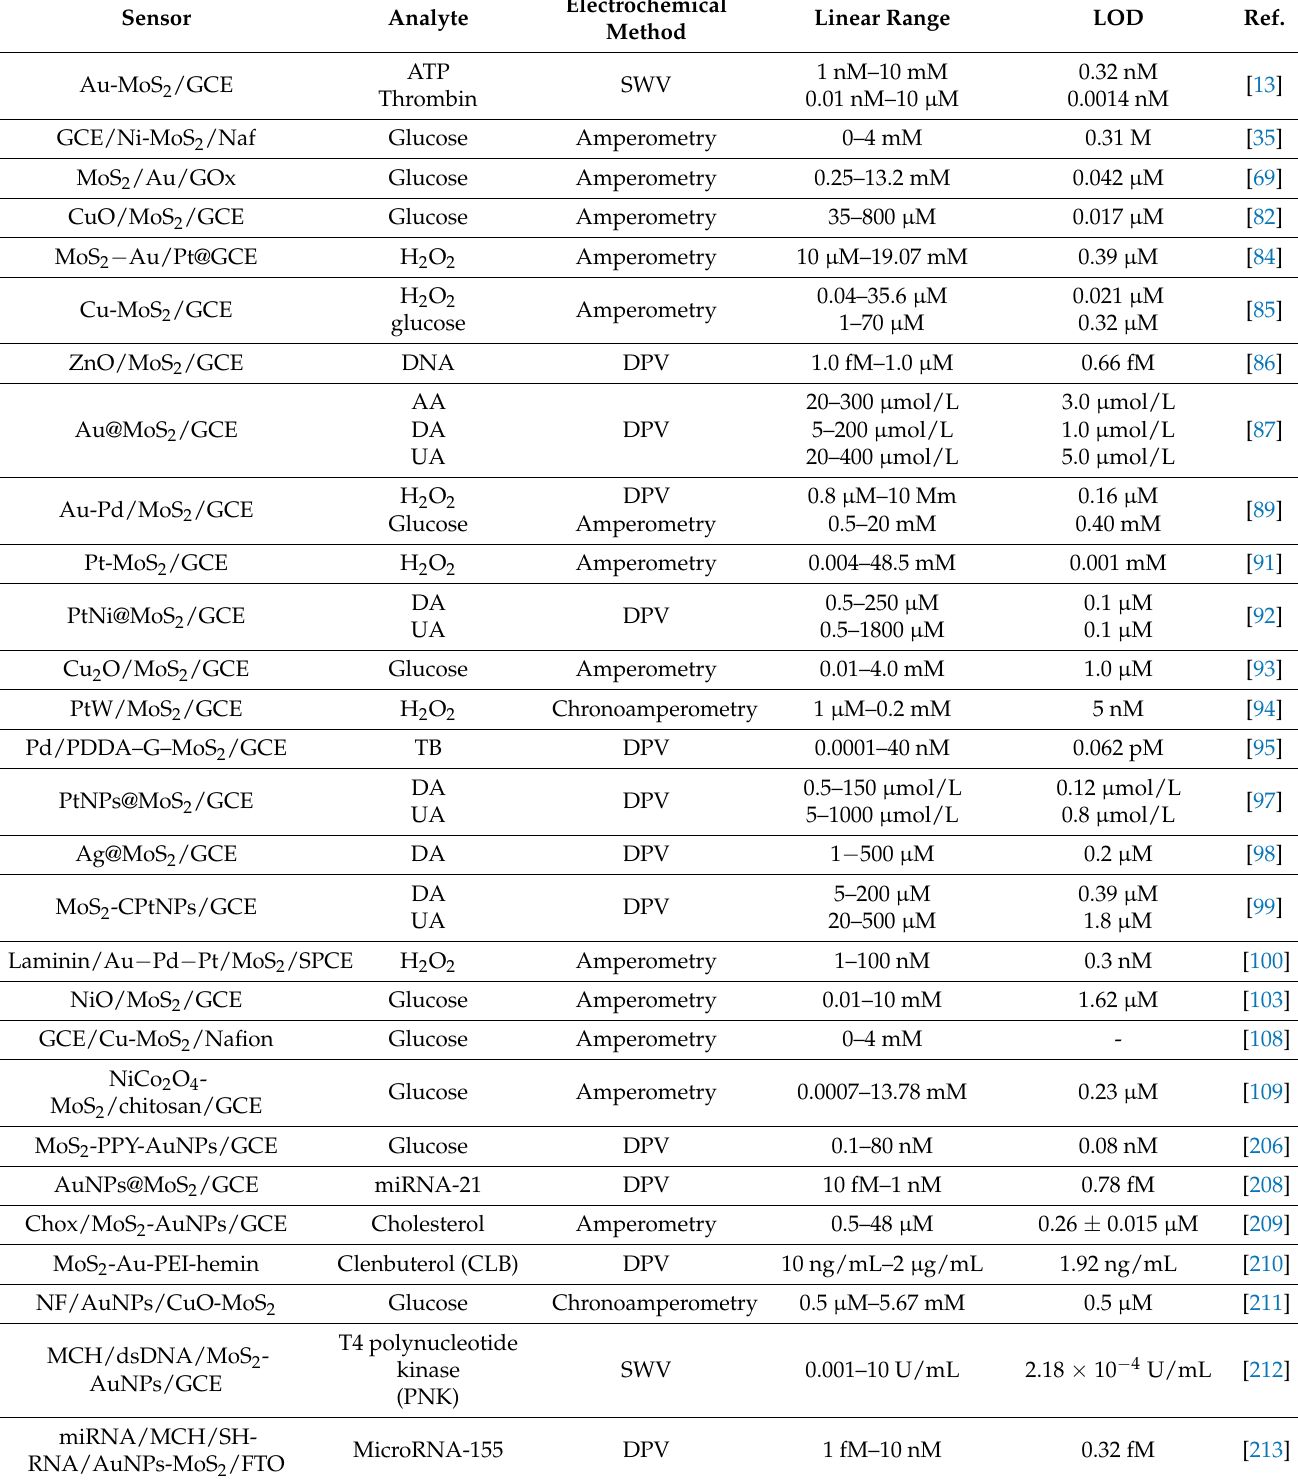
Table 2. Electrochemical biosensors based on 2D-MoS 2 /metal-NSs